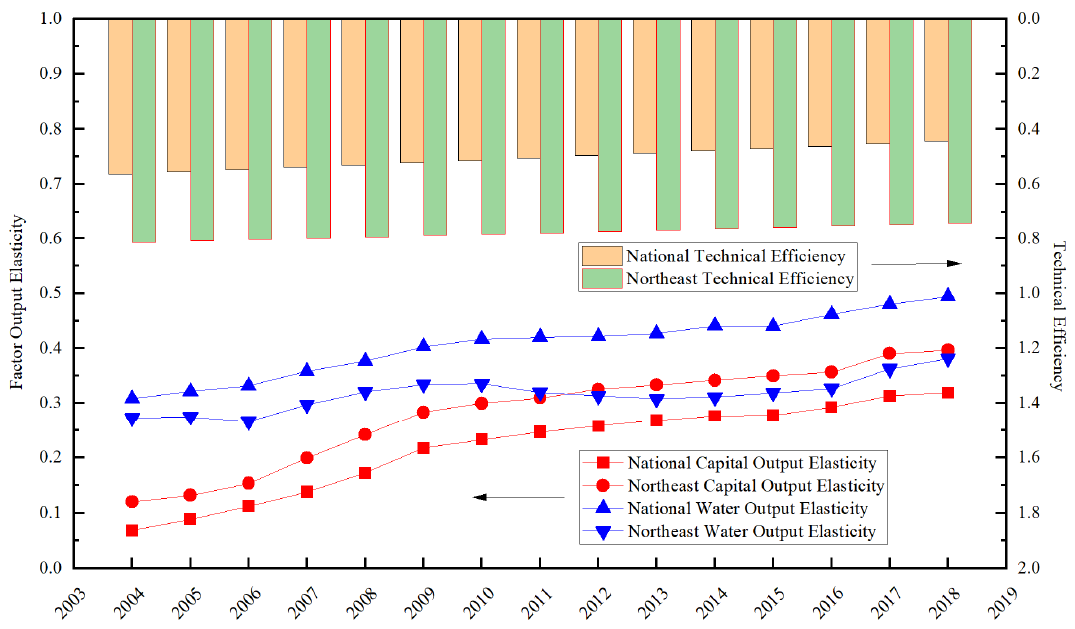
Figure 7. Comparison of technical efficiency and capital and water output elasticity between the nation and Northeast year by year.